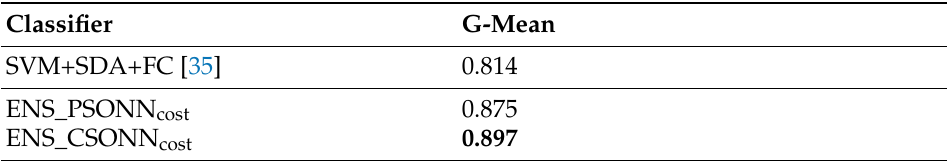
Table 17. The best results for the g-mean scores that were obtained in the related work compared to those of the two methods that are proposed in this work using the dataset of Taiwanese companies. The best g-mean result is marked in